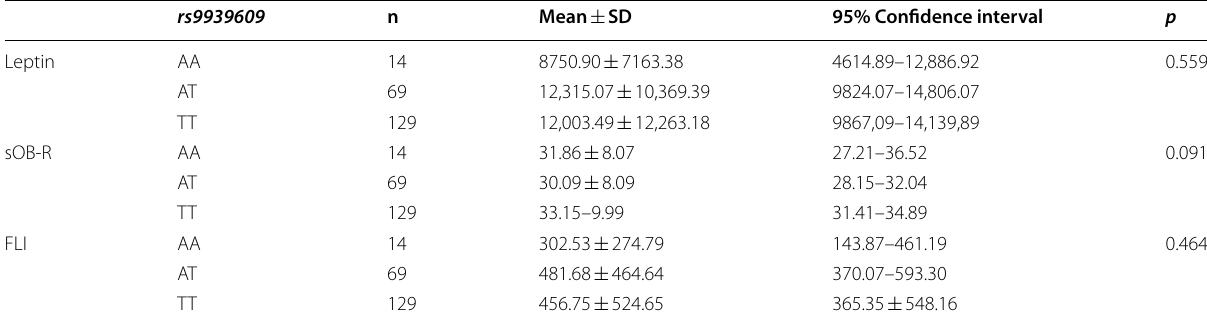
Table 2 Association between Leptin, Soluble Leptin Receptor and Free Leptin Index with Polymorphism rs9939609 (FTO